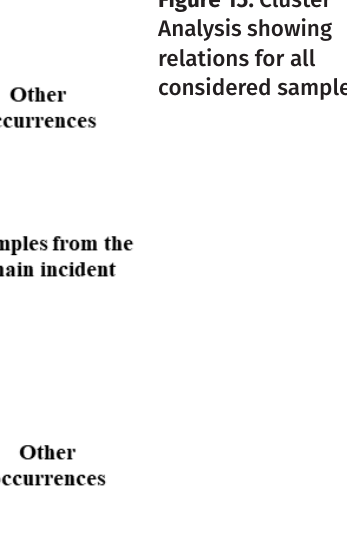
Figure 15. Cluster Analysis showing relations for all considered